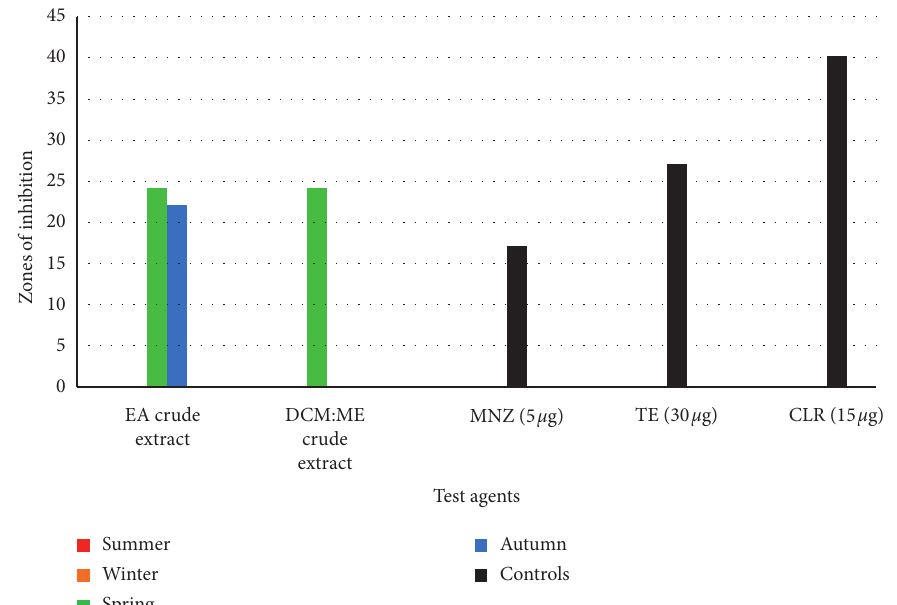
Figure 4: Antibacterial activity of ethyl acetate (EA) and dichloromethane: methanol (DCM:ME) crude extracts against C. difficile .